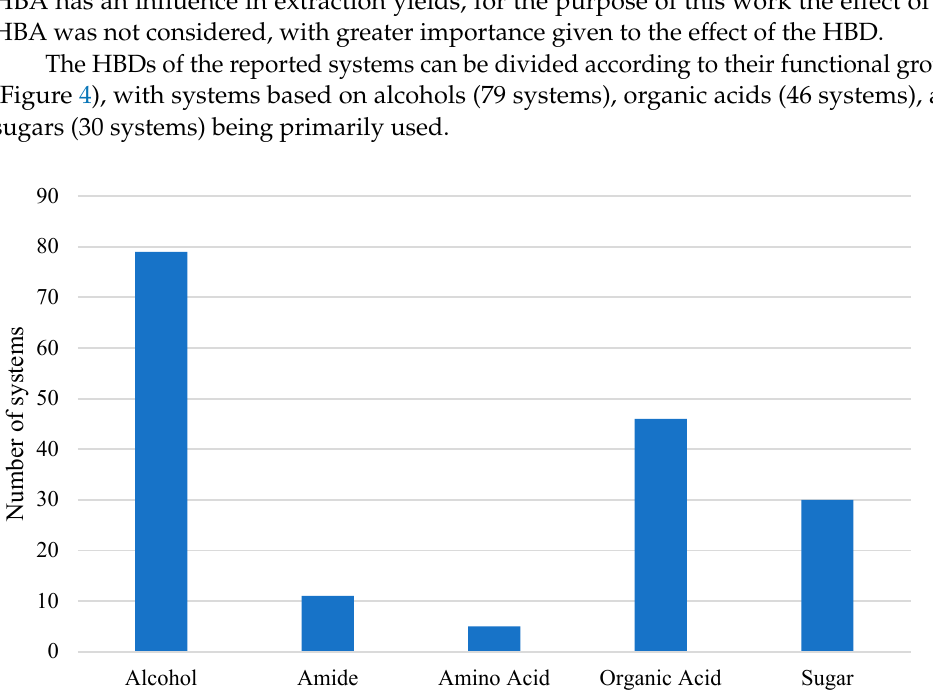
Figure 3. Chemical structures of commonly found phenolic compounds.